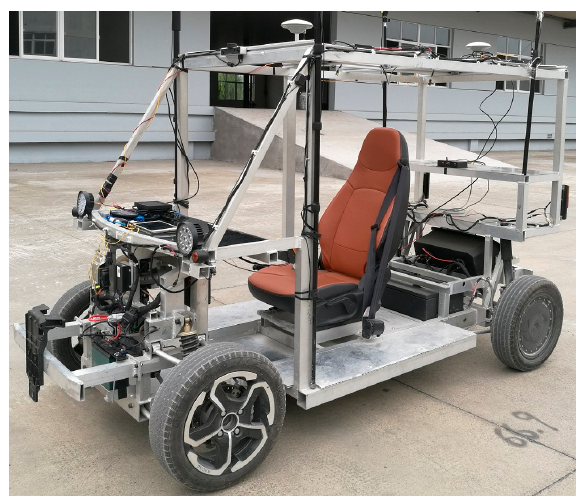
Figure 2. Experimental vehicle platform: Vehicle_a27.